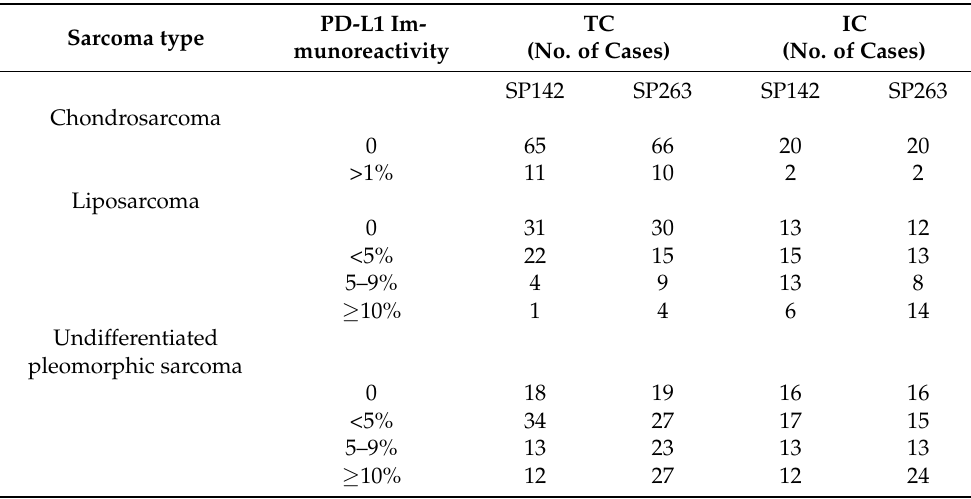
Figure 1. ( A ) Magnetic resonance imaging depicting chondrosarcoma (CS) in the humerus (arrow) and ( B ) histology of high-grade CS stained with ( C ) SP142 and ( D ) SP263 assays at × 200 magnification showing a higher number of cells with PD-L1 immunoreactivity using the SP263 assay. ( E ) Clinical and tumor characteristics of the CS cohort. Table 1. PD-L1 immunoreactivity in chondrosarcomas, liposarcomas and undifferentiated pleomor- phic sarcomas stained with SP142 and SP263 immunoassays